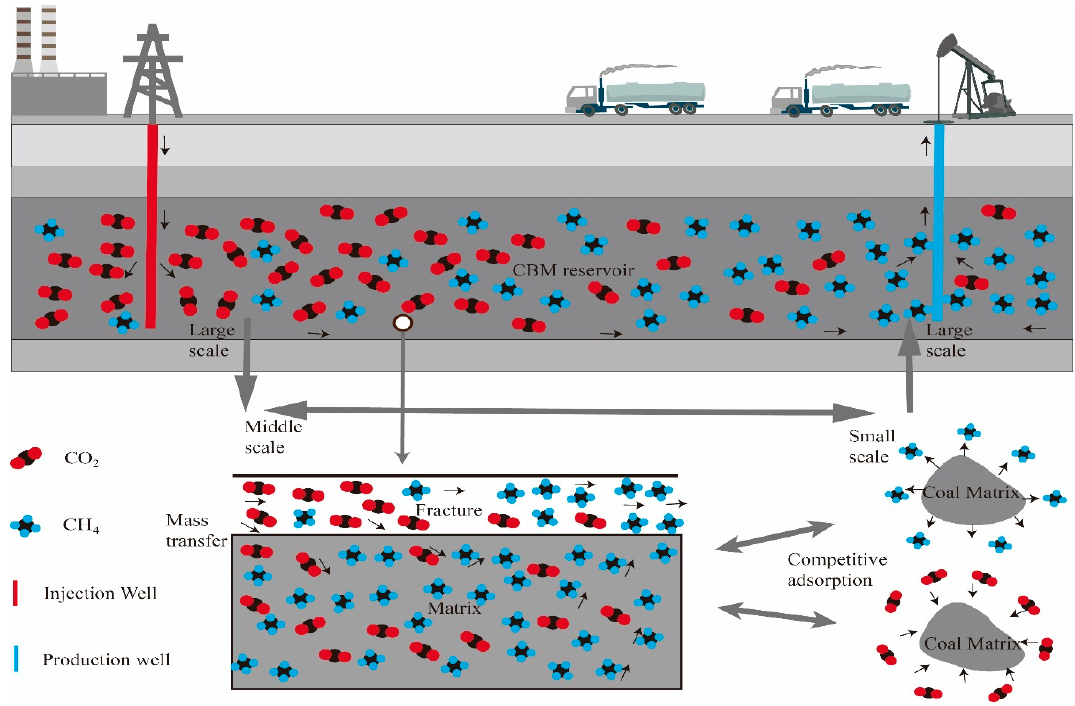
Figure 1. Schematic of CO 2 -enhanced coalbed methane (CO 2 -ECBM) recovery from different scales.